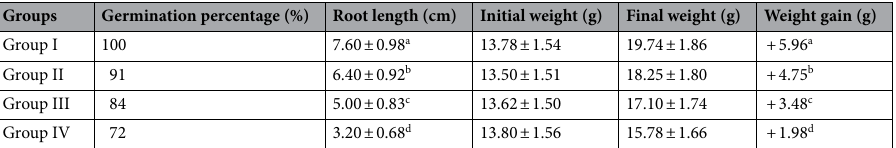
Table 1. Physiological effects of MnCl 2 toxicity. Group I: Control, Group II: 250 µM MnCl 2 , Group III: 500 µM MnCl 2 , Group IV: 1000 µM MnCl 2 . Data are shown as mean ± SD. 50 bulbs were used to determine germination percentage, and 10 bulbs were used to determine root length and weight gain. The averages shown with different letters (a–d) in the same column are statistically significant at p <